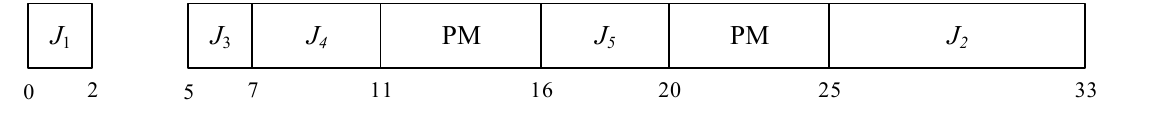
Figure 3. Gantt chart obtained by DP method.